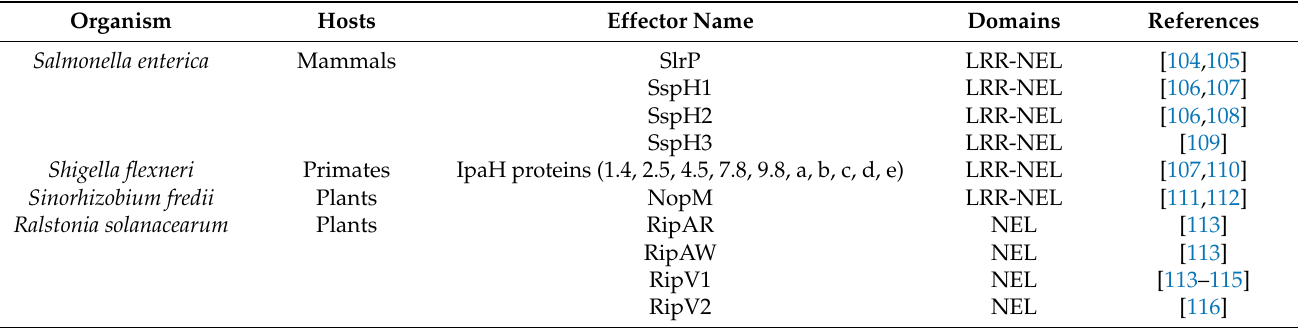
Table 1. Representative NEL T3SS